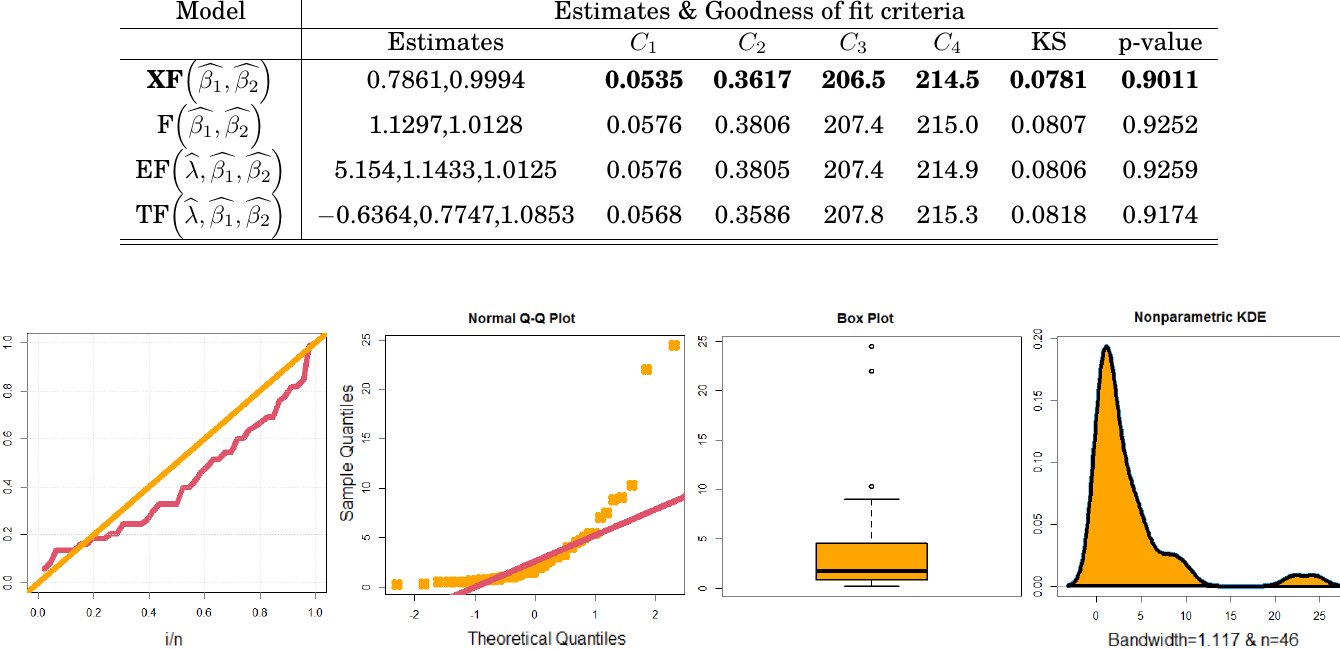
, C , C , C , KS and KS p-value for the repair times data set. 1 2 3 4